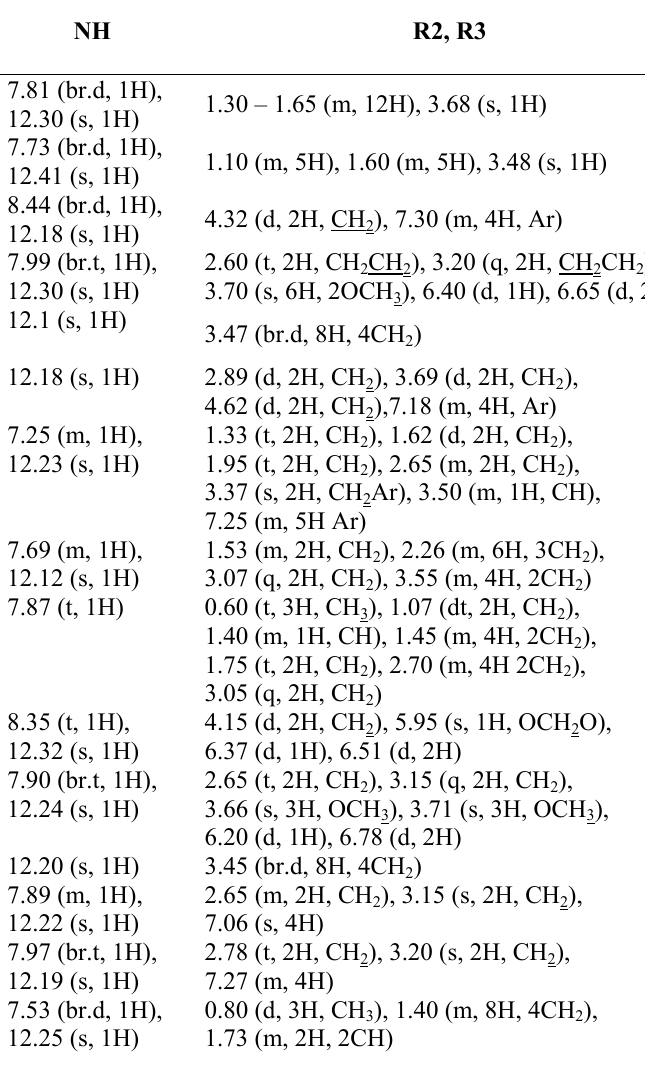
Table 4. 1 H-NMR -spectra of 3-[4-(R 1 -coumarin-3-yl)-1,3-thiazol-2-ylcarbamoyl]propanoic acids amides